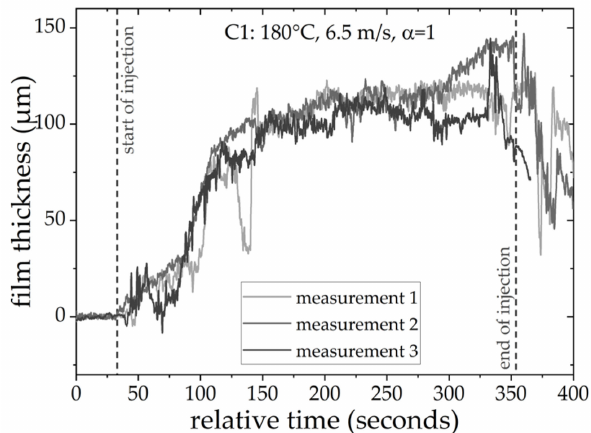
Figure 7. Repeated measurements of the first operating point C1 (180 ◦ C, 6.5 m 3 m dashed vertical lines marked the beginning and end of AdBlue